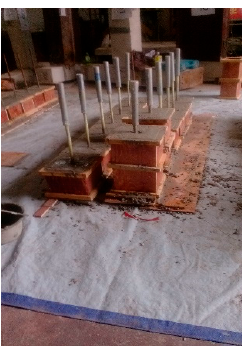
Figure 2. Assembled steel cages. Figure 3. Pullout specimens.